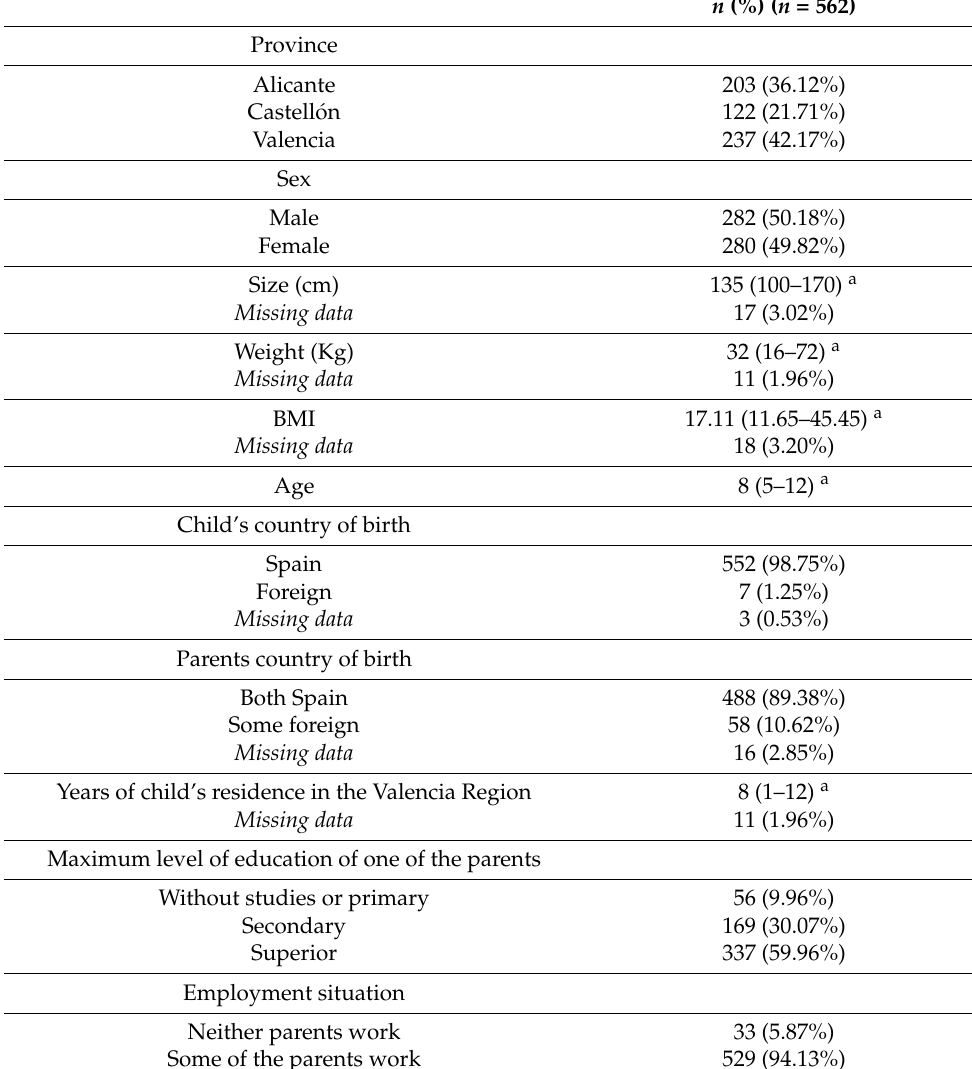
Table 1. Studied population